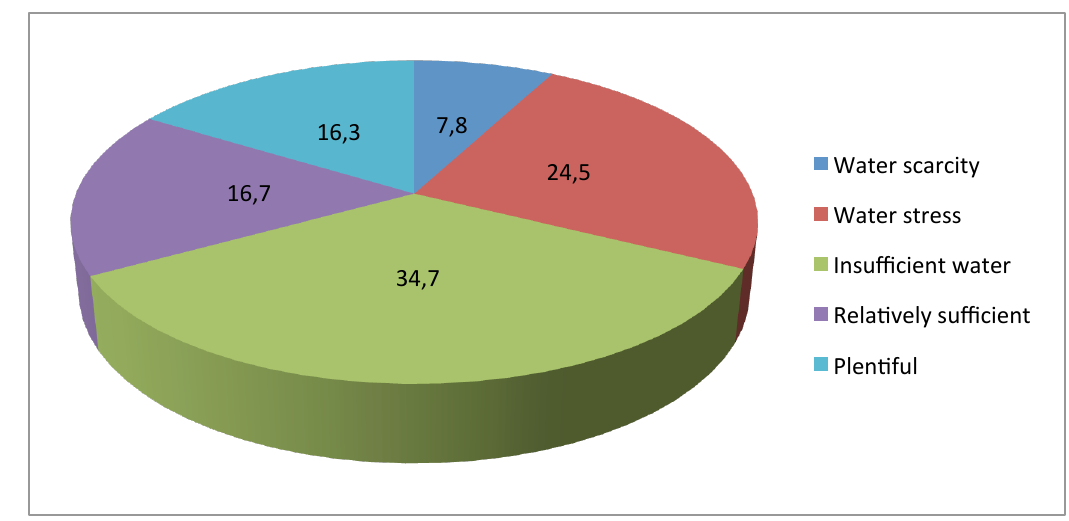
Figure 1 Percentage of the world population living in each of the five water availability categories (Source: Clarke and King,